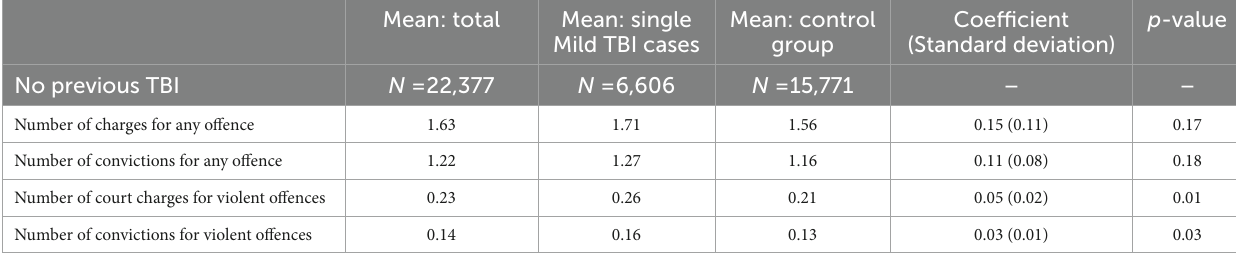
TABLE 1 Criminal behaviour outcomes between single mTBI cases and the orthopedic control